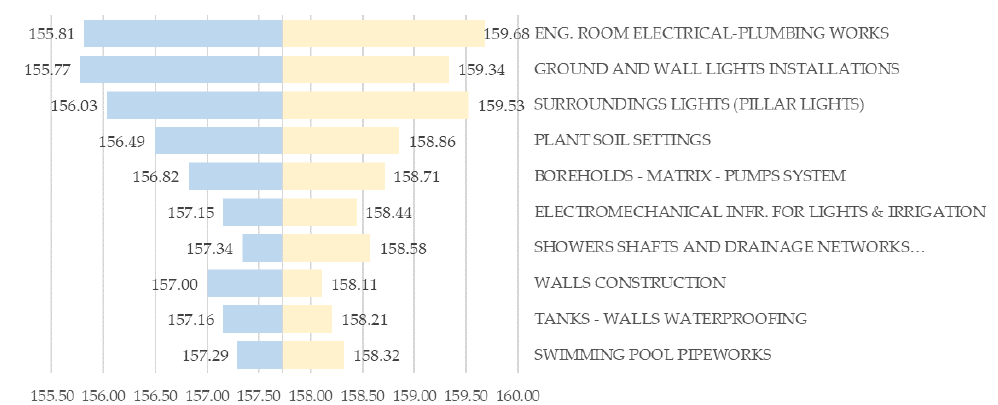
Figure 3. Tornado graph for the ten most important activities for the total project duration.